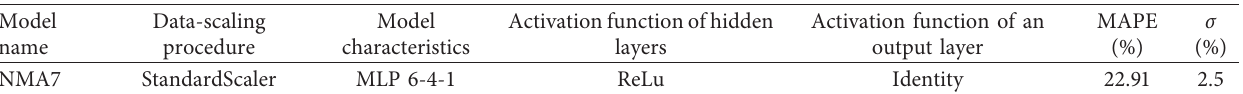
Table 11: Artificial neural network models with random data choice for estimating reinforcement consumption ( k -fold cross-validation, k � 10).